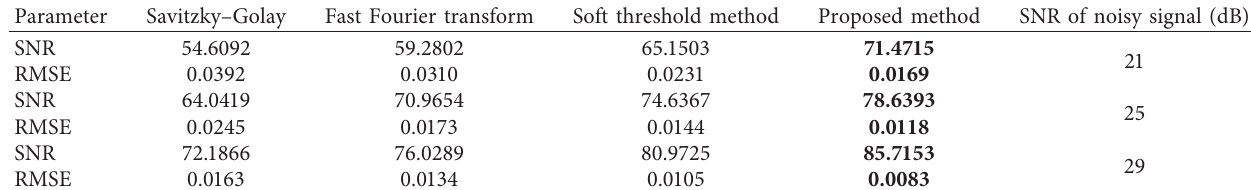
Table 2: Comparison results of simulation signal denoising with different methods.